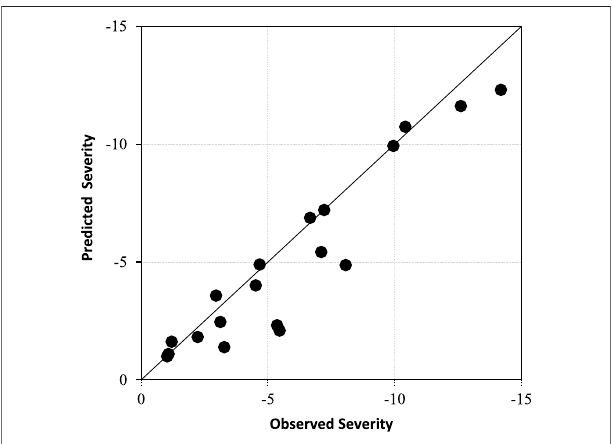
FIGURE 12 | Comparison between observed and predicted drought